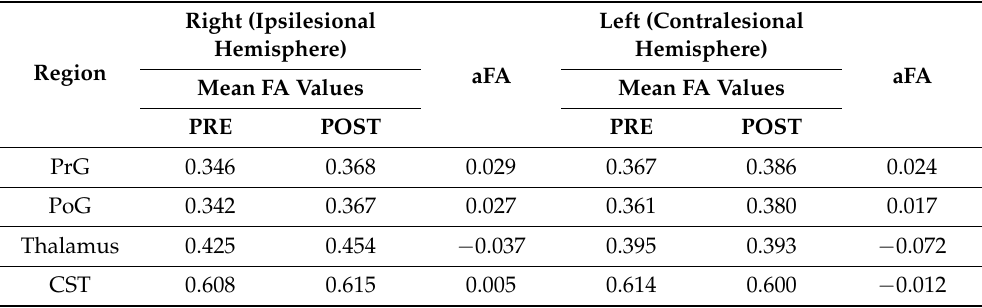
Table 3. Mean FA and aFA values obtained from pre-and post-VR therapy DTI in masked regions of patient ‘P’.